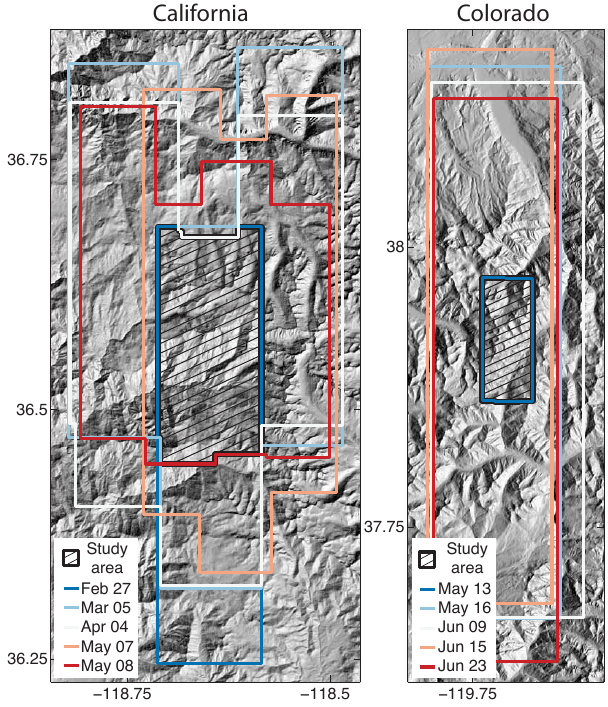
Figure 1. Geographic extent of the AVIRIS image data. The study area is shown hatched. It is based on a mosaic of subsets, such that a common area exists for all flight dates. The elevation model is hill shaded in the background with an illumination corresponding to the mean solar position for all